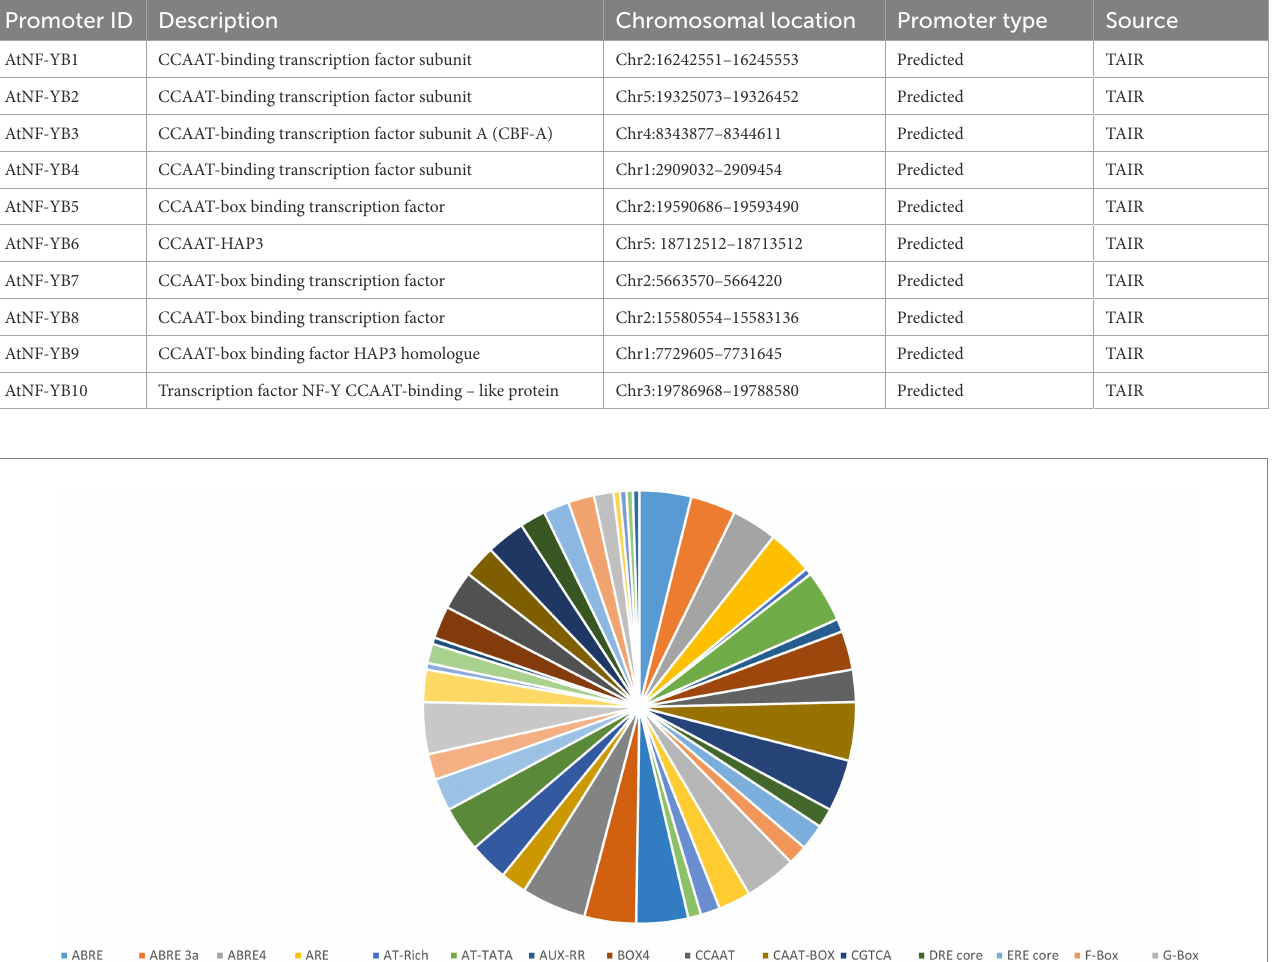
TABLE 4 Description of promoters and their chromosomal location utilising atcisDB from AGRIS database.